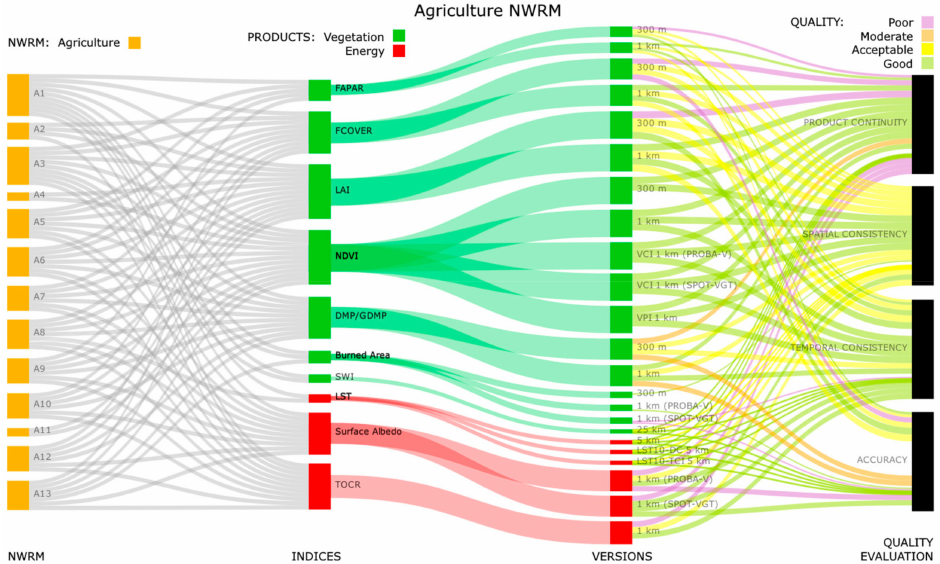
Figure A1. Sankey diagram linking the agriculture NWRM (A) and the CGLS vegetation and energy indices that are suitable for their monitoring, according to previous research experiences.